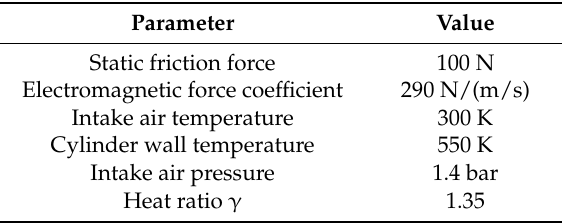
Table 5. Some parameters in the